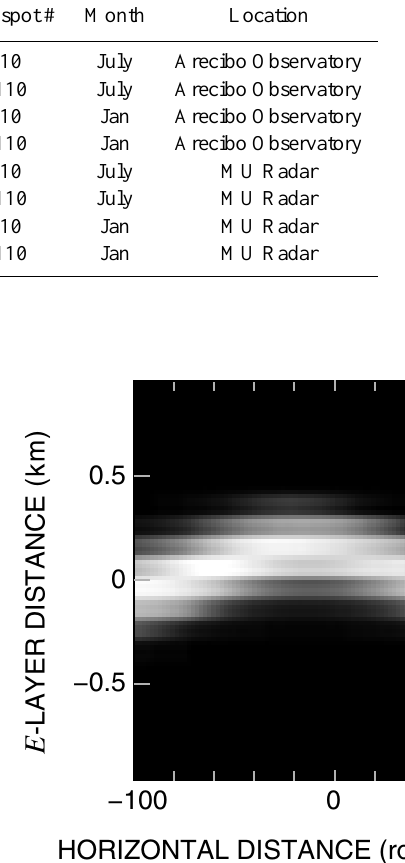
Fig. 7. The t = 60min panel of Fig. 6a with the ordinate scale magni- fied 100 times, showing the E s layer evolution in the linear regime. The boundary conditions are periodic in the horizontal